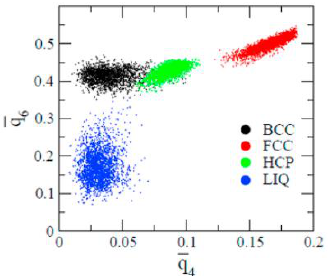
Figure 2. q 4 – q 6 map evaluated from molecular dynamics simulations performed using the Lennard-Jones potential for the bulk bcc, hcp, fcc, and liquid structures. (Reproduced with permission from Reference [46]).